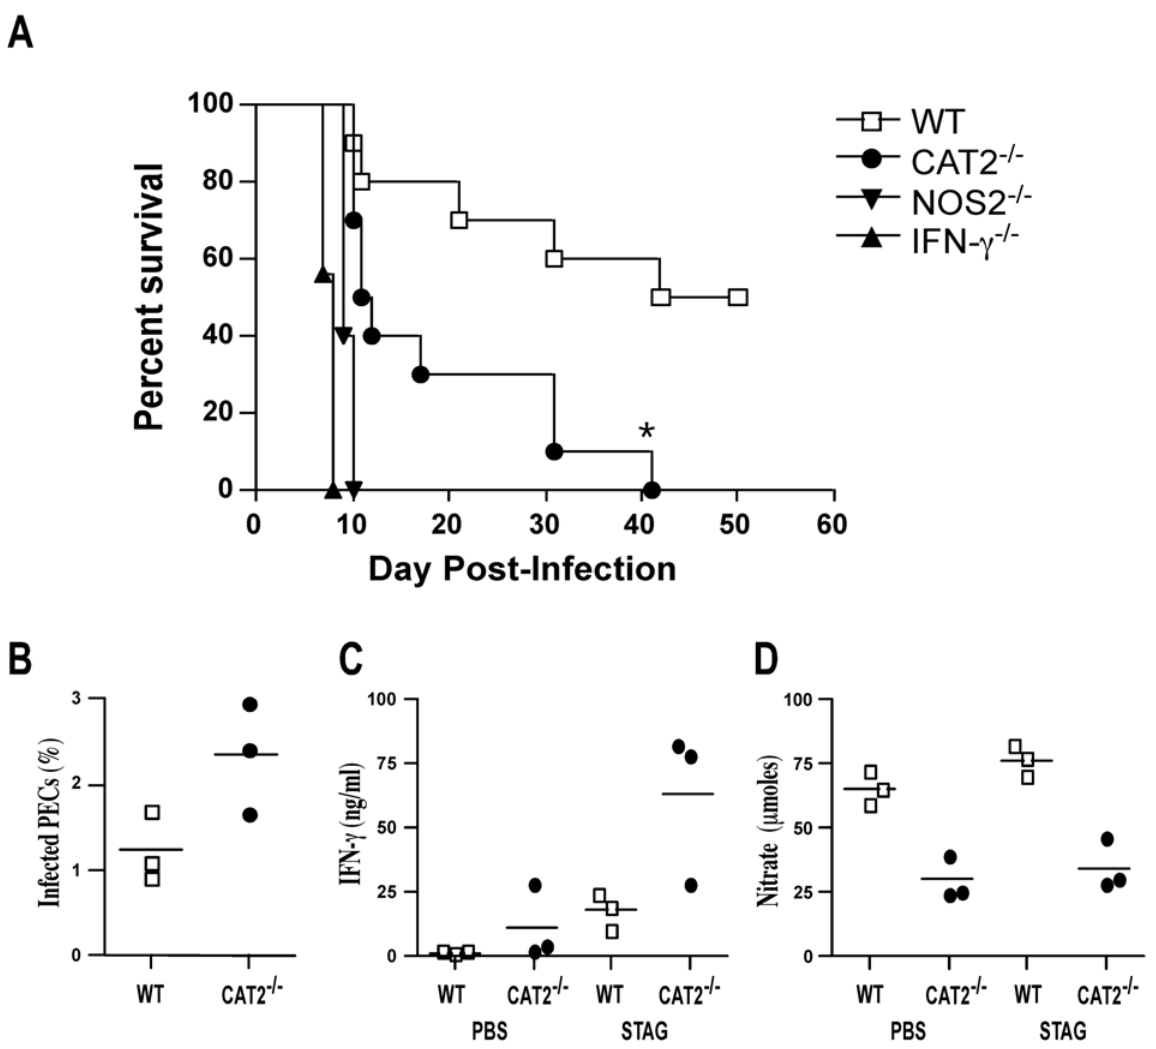
Figure 11. Development of Th1 immunity is compromised in CAT2 2 / 2 mice. A. WT C57BL/6 (open squares), CAT2 2 / 2 (filled circles), NOS2 2 / 2 (filled inverted triangles) and IFN- c 2 / 2 (filled triangles) mice were infected i.p. with 20 T. gondii cysts, and survival was assessed up to 50 days post-infection. (N=5/group). B. Peritoneal exudate cells (PECs) were prepared from WT and CAT2 2 / 2 mice on day 7 post-infection. The percentage of infected cells was determined microscopically by evaluating a minimum of 700 cells per slide (3 mice/group). C. PECs were placed in culture for 24–48 hr and either left untreated or restimulated with STAG. Culture supernatants were collected and IFN- c levels were determined by ELISA. D. NO activity was evaluated in the same culture supernatants by measuring nitrate